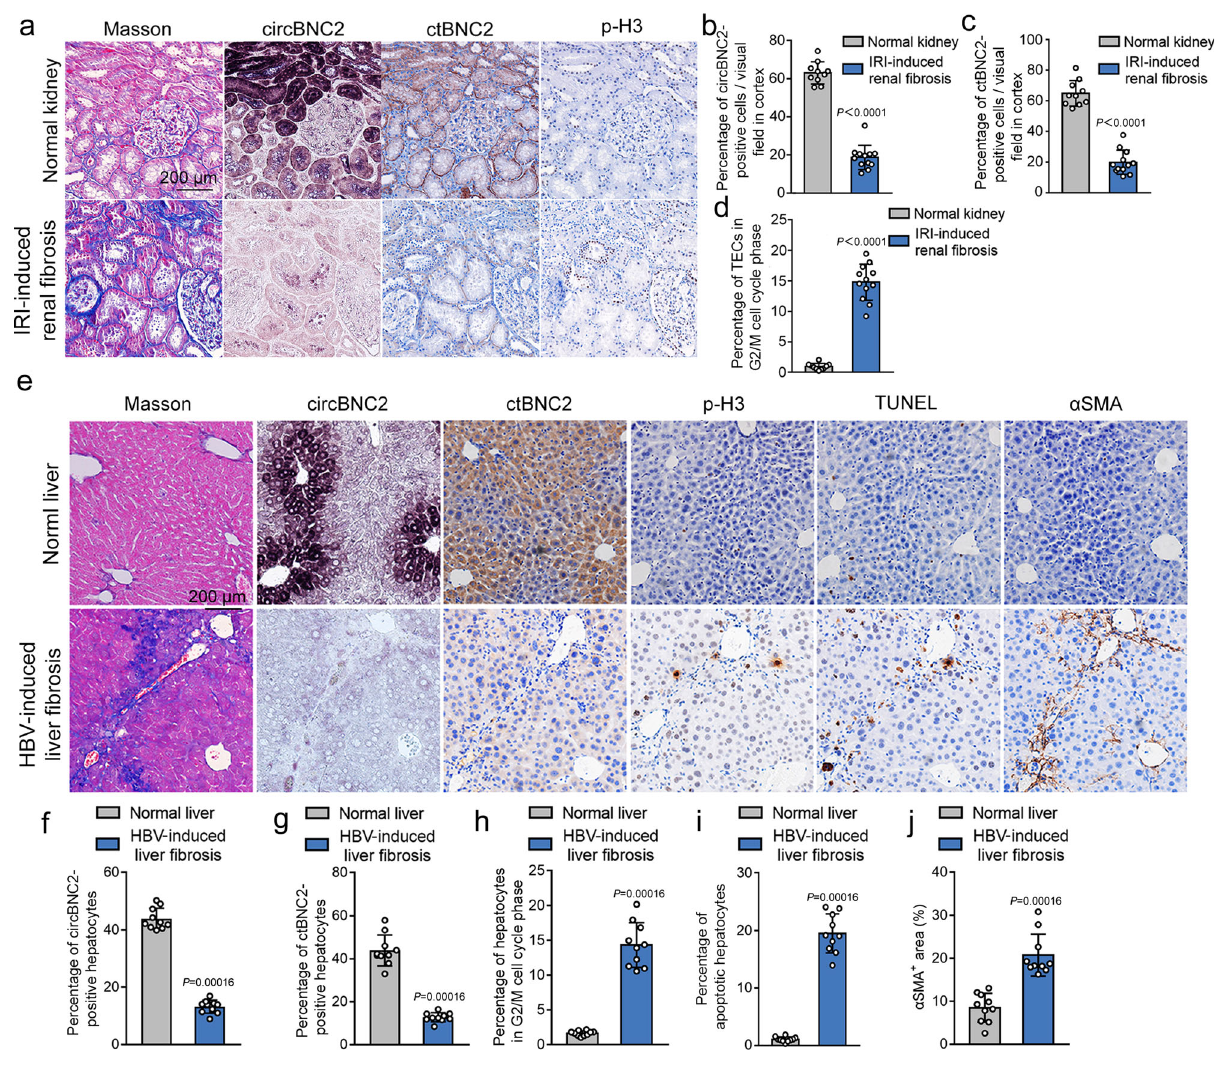
Fig. 7 | Downregulation of circBNC2 and ctBNC2 associates with epithelial cell G2/M arrest in human fi brotic kidney and liver. a – d Representative